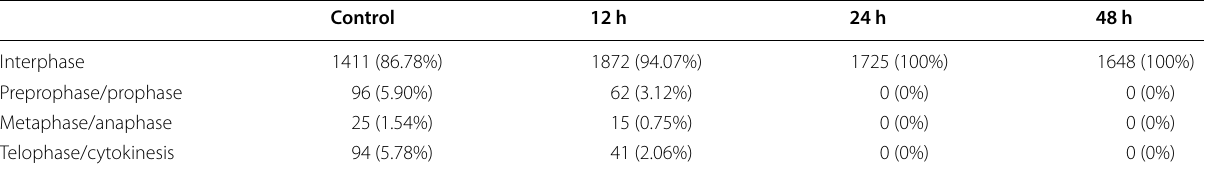
Table 1 Number and percentage of cells at various cell cycle stages, in the meristematic root zone of control and aphidicolin-treated